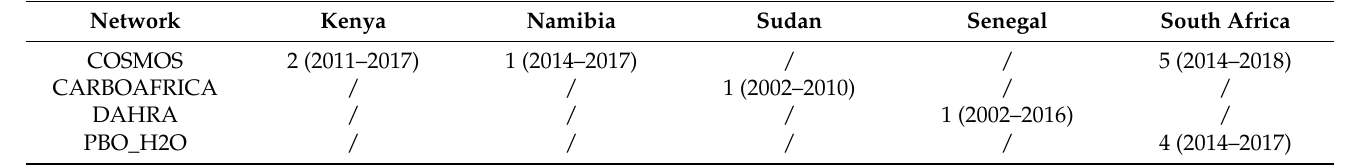
Table 2. Information about in situ ground soil moisture observation networks and sites in